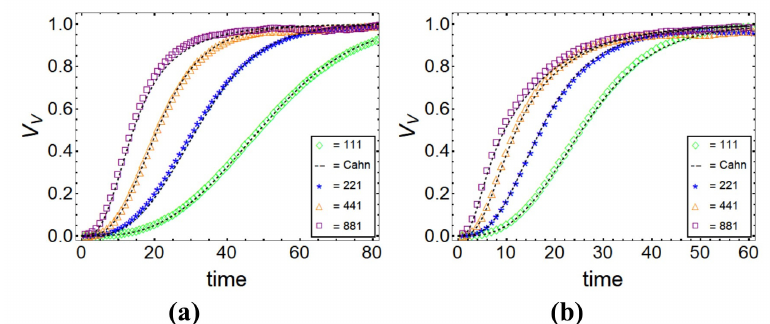
Figure 6. Effect of the aspect ratio and the number of nuclei per plane on the transformation kinetics of oblate ellipsoids. The nucleation was site-saturated. That is, all nuclei started to grow at the time origin: t 0 = . The symbols correspond to the computer-simulated result, whereas the dashed line was calculated using Cahn’s model modified for ellipsoids. On each figure, the curves show the effect of the ratio of the length of the longer axes to the shorter axis of the ellipsoids. Figure 6a depicts the transformation kinetics of oblate ellipsoids nucleated on 20 random parallel planes with 10 nuclei per each plane. Figure 6a depicts the transformation kinetics of oblate ellipsoids nucleated on 20 random parallel planes with 80 number of nuclei per